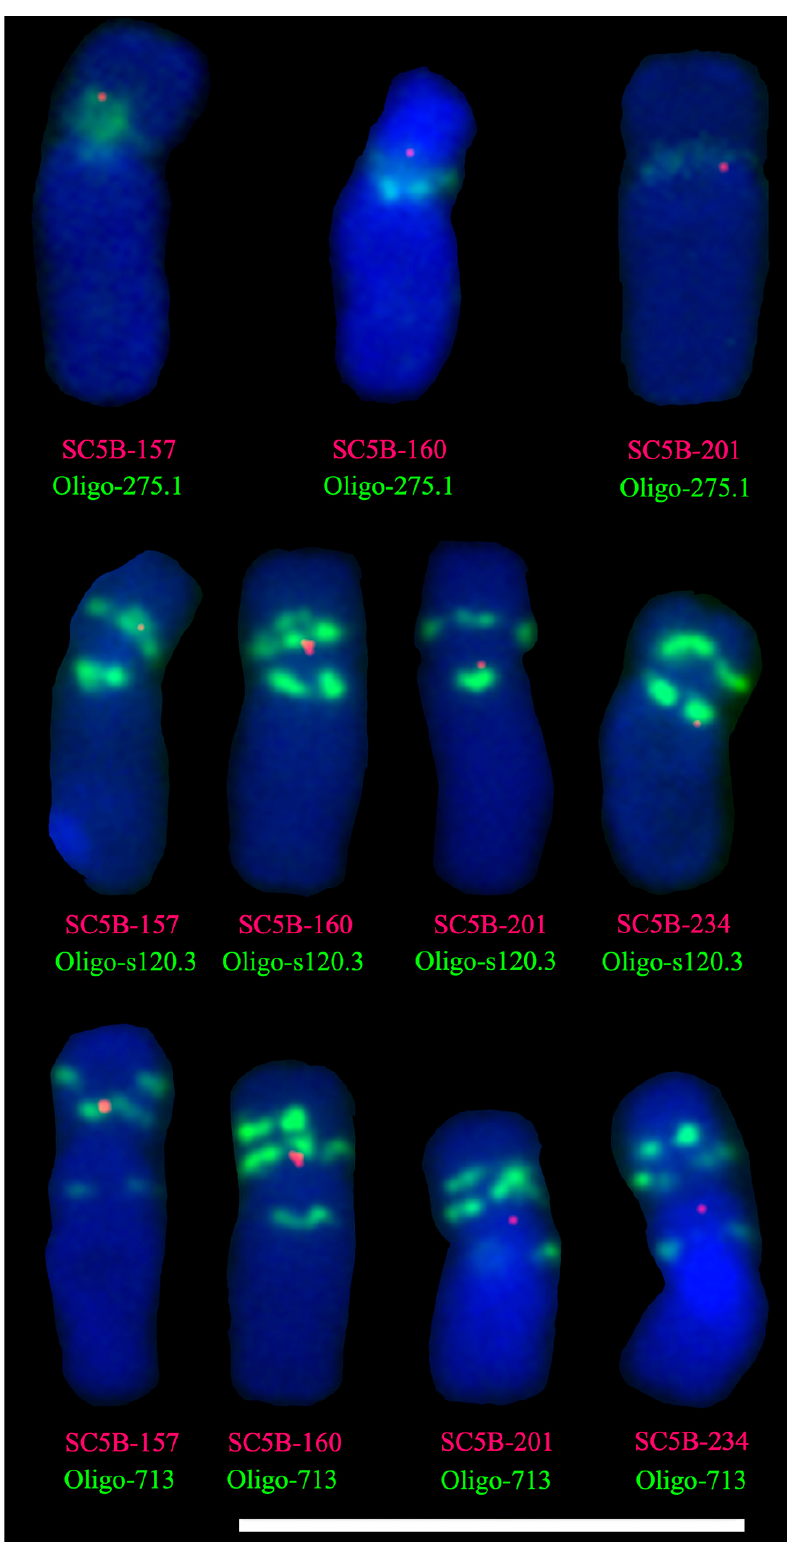
Figure 3. FISH analysis of chromosome 5B of wheat Chinese Spring using single-copy probes SC5B-157 (red), SC5B-160 (red), SC5B-158 (red), SC5B-201 (red), and SC5B-234 (red), and oligo probes Oligo-s120.3 (green) and Oligo-713 (green). Cut-and-paste chromosomes are displayed. Scale bar: 100 µ